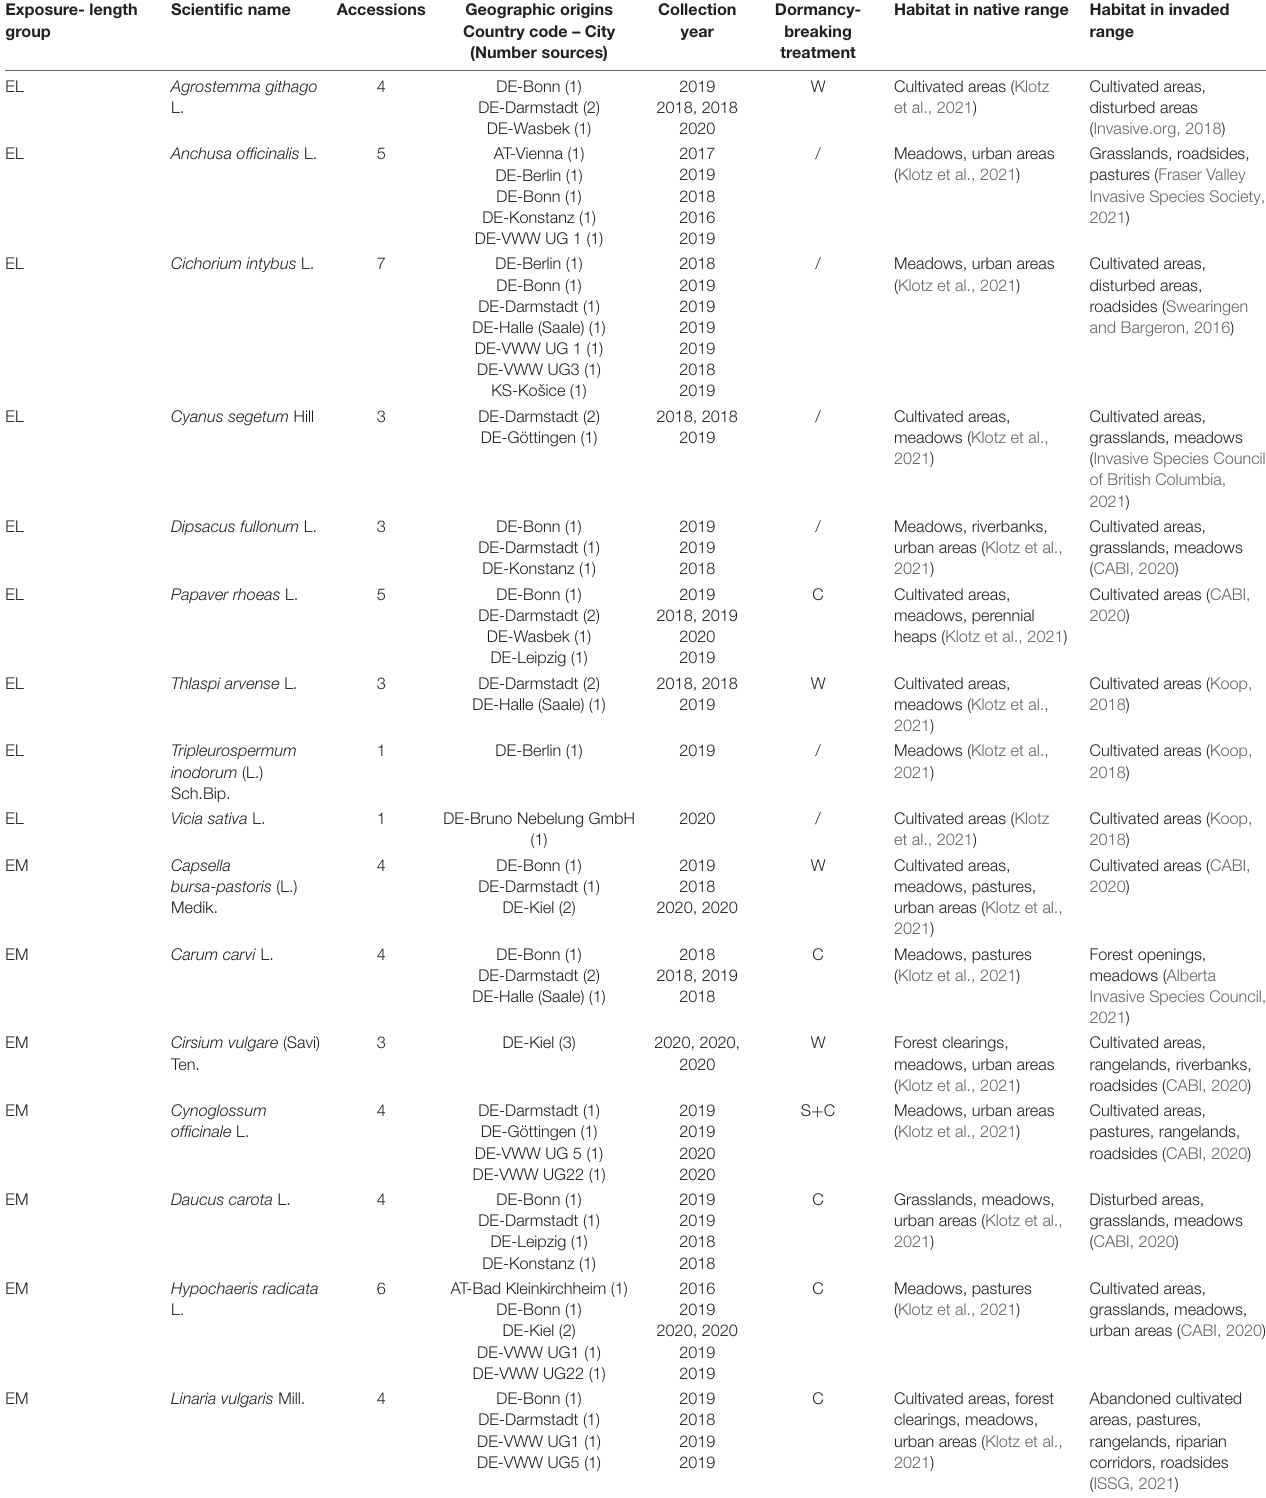
TABLE 1 | Overview of species composition, seed material accessions and seed pre-treatments of the three target groups of plants: EL, EM, and ES, respectively, long-, medium-, and short- assumed exposure to agropastoralism. Exposure- length